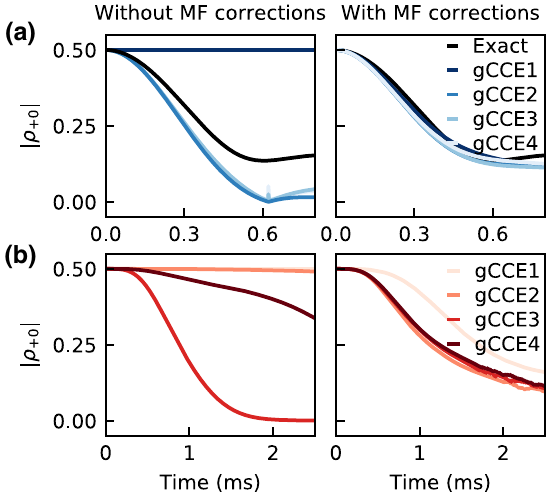
FIG. 7. Single defect coherence of the basal kh divacancy in 4 H -SiC predicted by different theoretical approximations. (a),(b) The absolute value of the off-diagonal elements of the density matrix | ρ 0 + | = | (cid:4) 0 | ˆ ρ |+(cid:2) | for one random nuclear con- figuration corresponding to Ramsey (a) and Hahn-echo (b) exper- iments. The results of the gCCE at different orders (from 1 to 3) without mean-field (MF) interactions (left) and with mean-field corrections (right). The exact solution for a bath of nine nuclear spins for the Ramsey decay is shown as a black line.